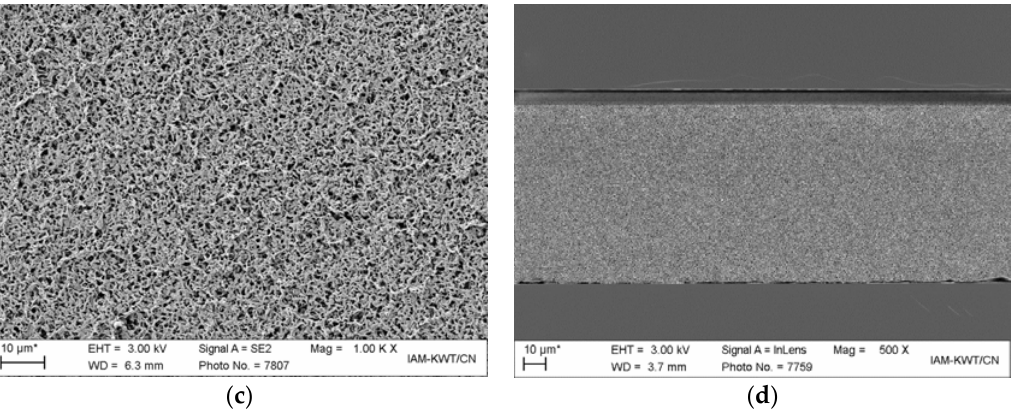
Figure 3. SEM images of the surface of membrane M-1 ( a , b ) and M-2 ( c , d ) in selected magnifications. ( a , c ): top side after membrane preparation; ( b , d ): cross section of the membrane. See Figures S4 and S5 (see Supplementary Materials) for detailed SEM images.